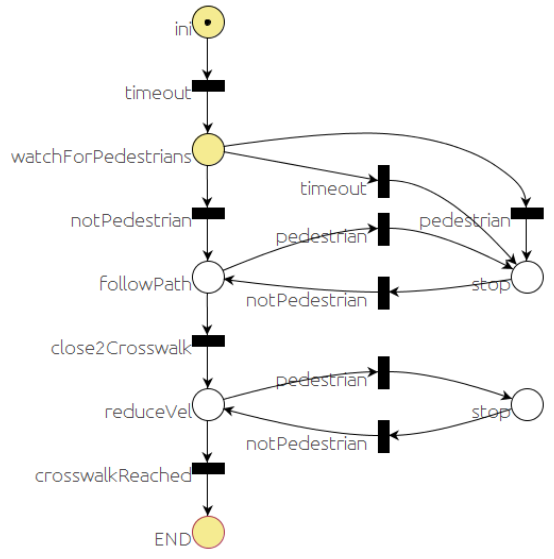
Figure 6. Crosswalk behavior